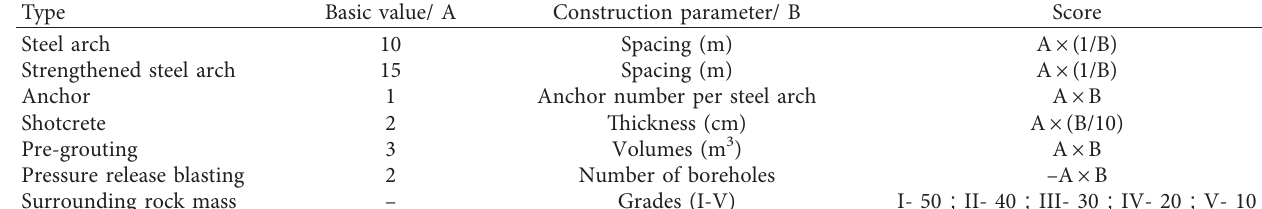
Table 1: Stiffness score of support and surrounding rock in Micangshan tunnel [28].